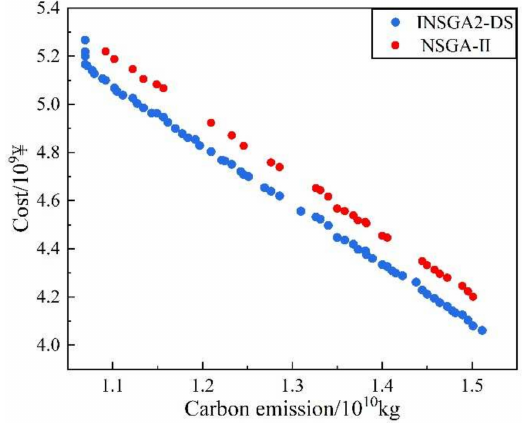
Figure 22. NSGA-II and INSGA2-DS optimization results.